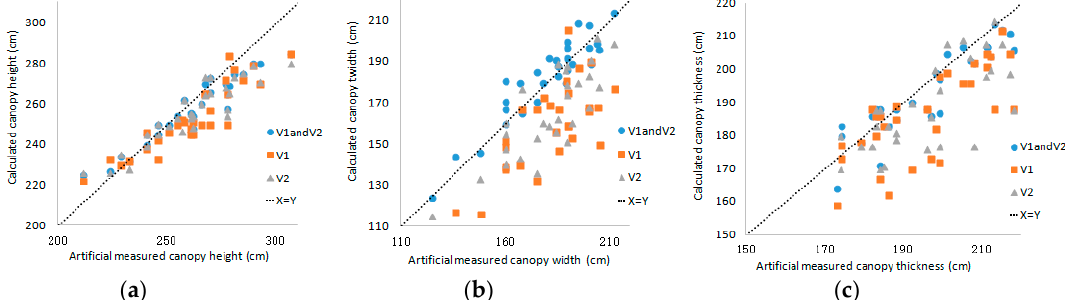
Figure 11. Measured and calculated values for H, W and D: ( a ) data comparison between the manually measured values and the calculated values for the fruit tree canopy H; ( b ) data comparison between the manually measured values and the calculated values for the fruit tree canopy W; ( c ) data comparison between the manually measured values and the calculated values for the fruit tree canopy D.